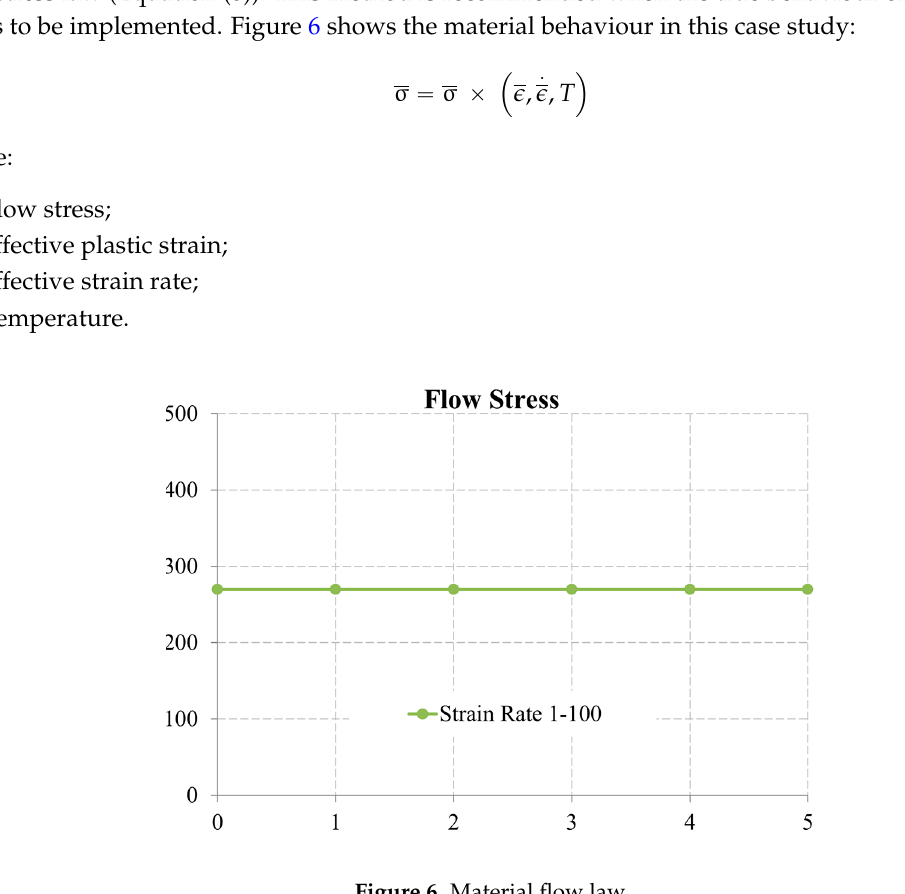
Figure 5. Mesh window display.